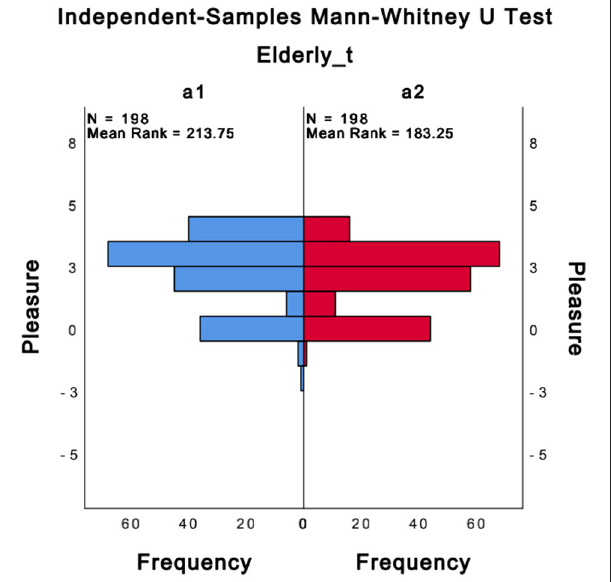
FIGURE 1 | Mann-Whitney U test (Pleasure in a1 and